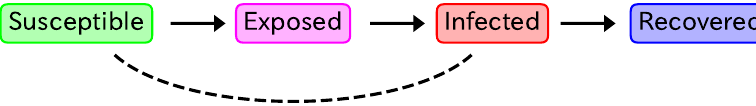
Figure 13. The illustration of the scheme of the SEIR